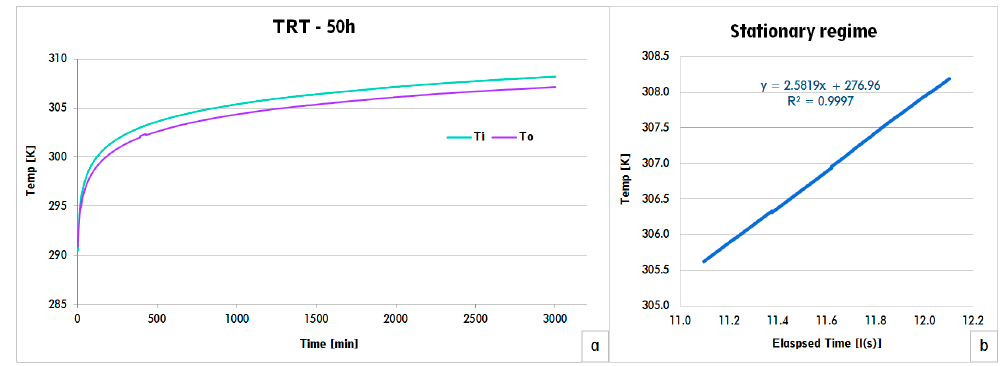
Figure 7. ( a ) TRT results for the time lapse of 50 h, ( b ) stationary regime considering 1900 sampling values.